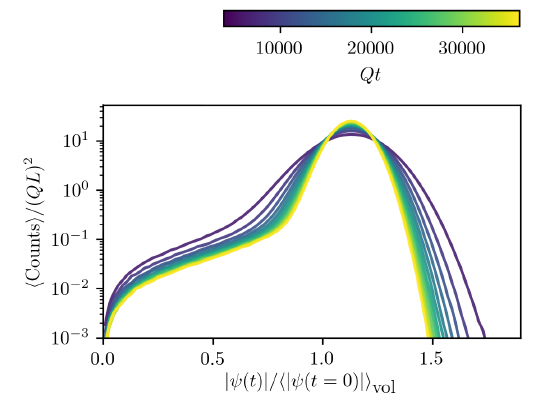
Figure 9: Distribution of amplitude-values at different times, averages taken across classical-statistical sampling runs.